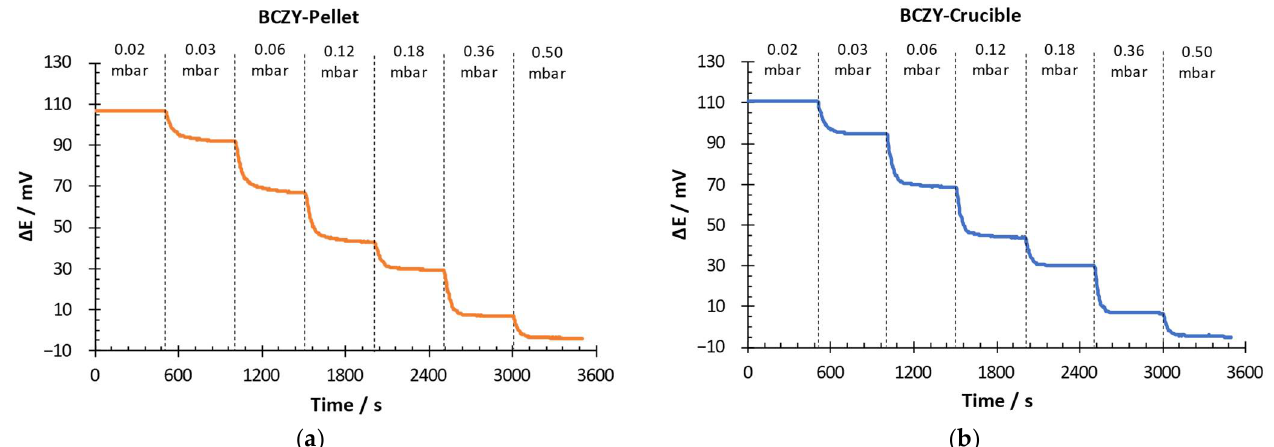
Figure 6. Potential difference-over-time measurement for ( a ) BCZY-Pellet and ( b ) BCZY-Crucible.